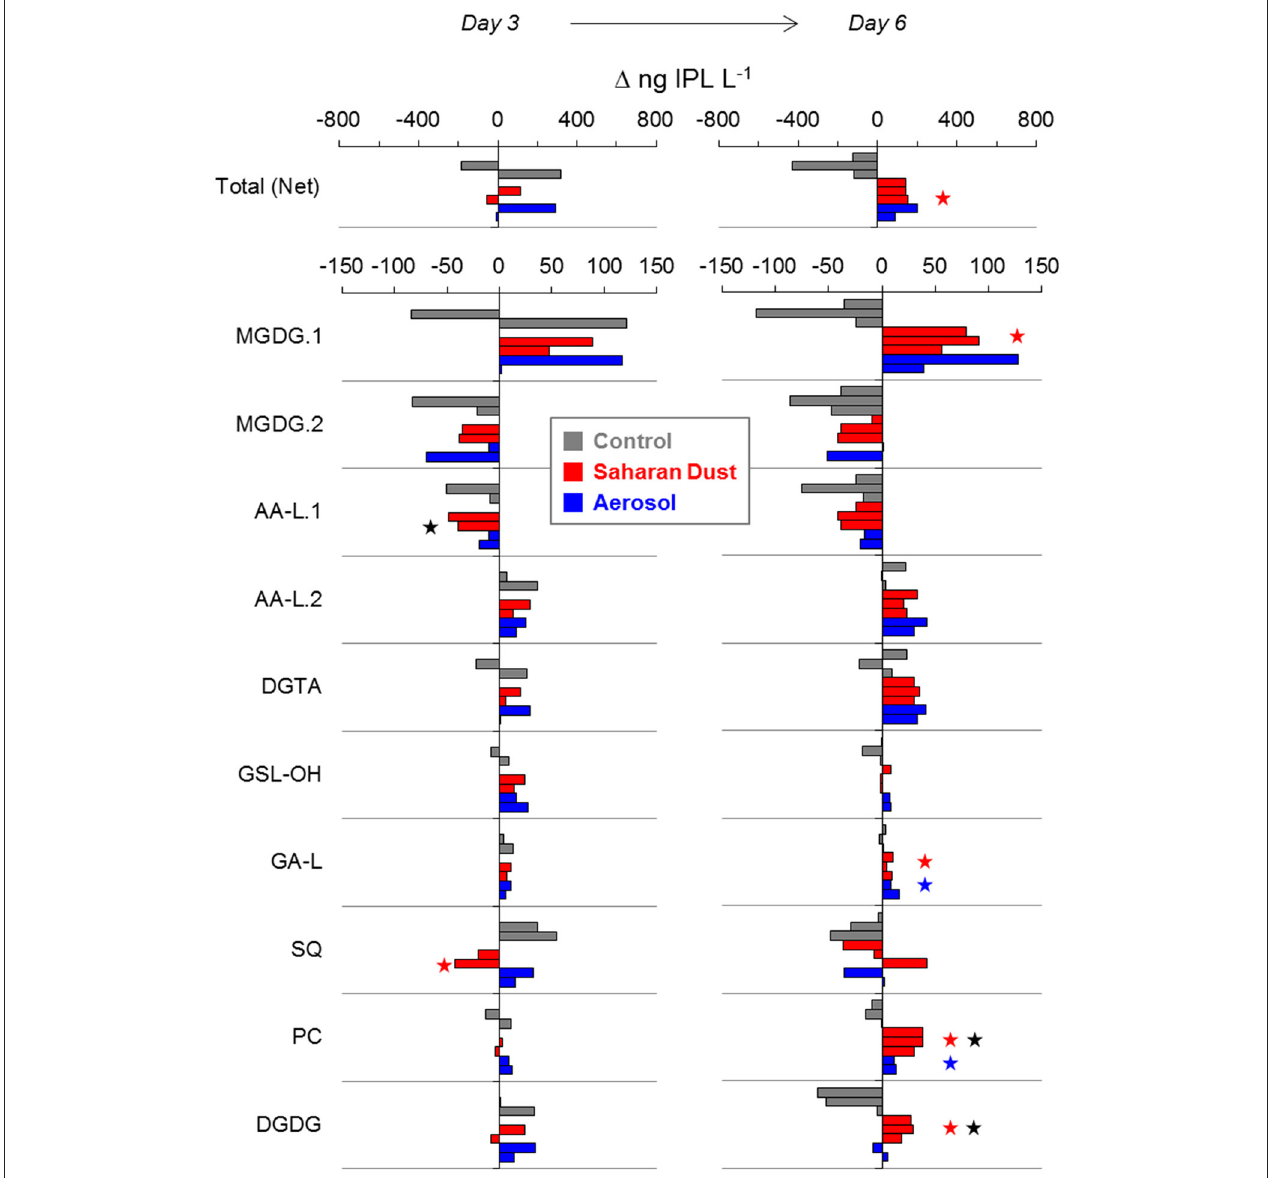
FIGURE 6 | Changes in IPL concentration relative to day − 1 in each replicate mesocosm of control (gray), Saharan dust (red), and mixed aerosol (blue) treatments. Significant differences to the control mesocosms are indicated by a red or blue star. Black stars indicate significant differences between Saharan dust and mixed aerosol mesocosms. Each bar represents one replicate mesocosm of each treatment, shown in consistent